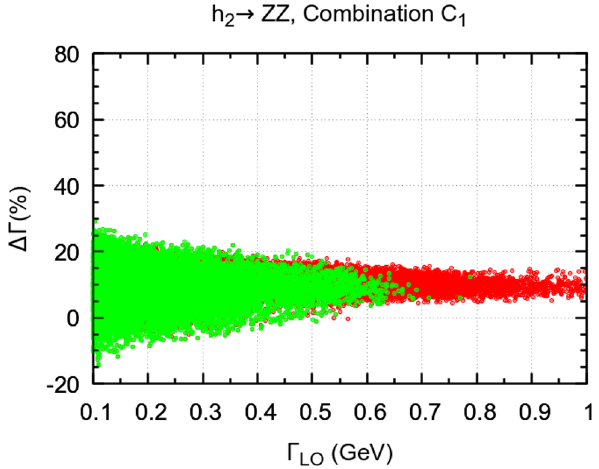
Figure 1 . ∆Γ h in percentage as a function of Γ LO , for the combination C 1 . Only the h 2 → ZZ 2 → ZZ interval 0 . 1 GeV < Γ LO < 1 GeV is shown. In red/dark-gray, points passing all constraints except HiggBounds-5 ; in green/gray, points passing all constraints.